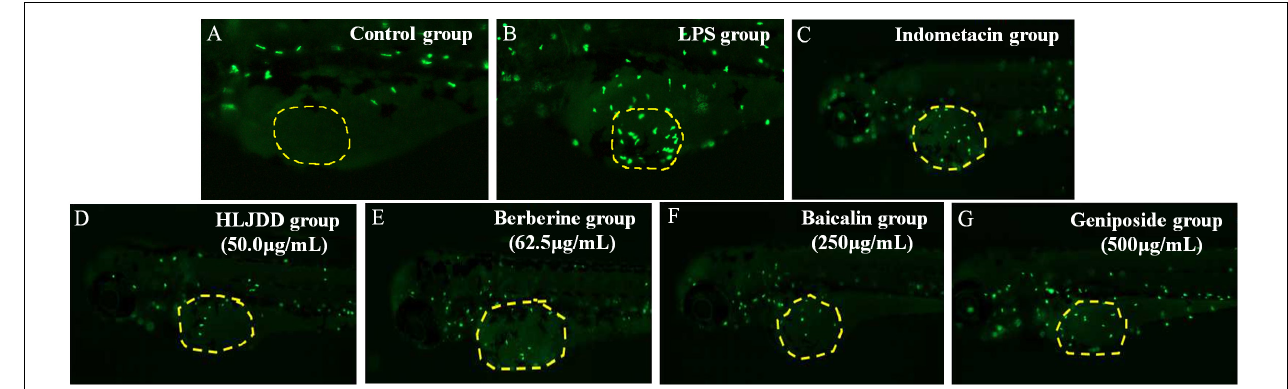
FIGURE 1 | Representative pictures of transgenic neutrophils labeling in zebrafish yolks at 3 dpf. (A) Control group. (B) Lipopolysaccharide (LPS) group. (C) Indomethacin group. (D) 50.0 µ g/mL Huanglian Jiedu decoction (HLJDD) group. (E) 62.5 µ g/mL Berberine group. (F) 250 µ g/mL Baicalin group. (G) 500 µ g/mL Geniposide group. Green fluorescence represents the transgenic neutrophils.